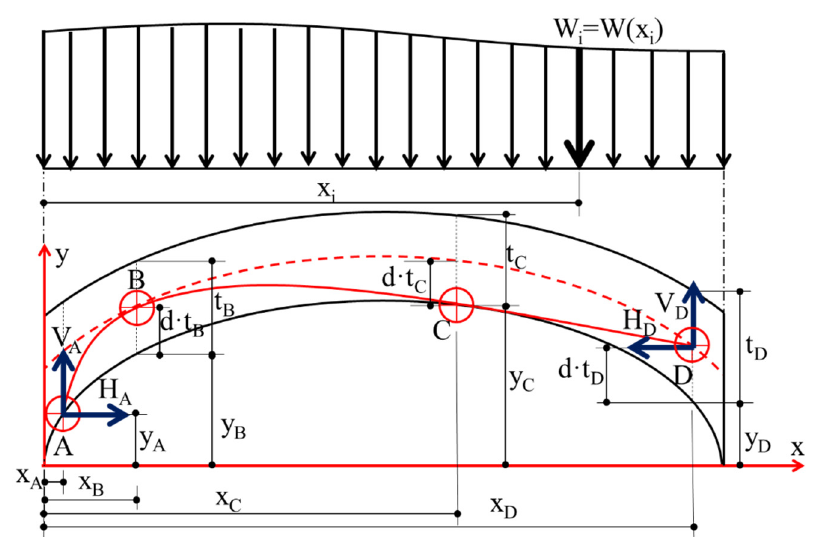
Figure 2. Equilibrium of a masonry arch under vertical loads W(x) , definition of the pressure line and location of hinges.